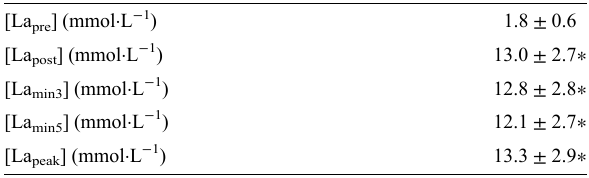
Table 1 - Blood lactate concentrations pre- and post-FT SESSION (n =